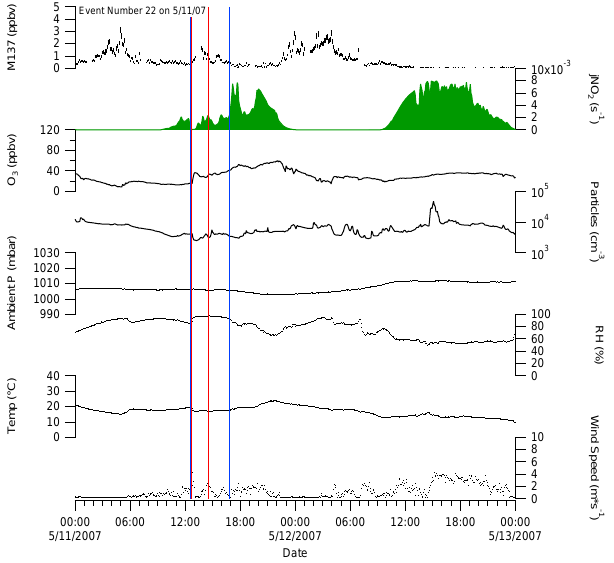
Fig. 5. An example of a Type C event, in which the storm pas- sage coincides with a decrease in monoterpene mixing ratios from 23 July 2005. In this example, no increase in precipitation rate be- yond 2.54mmh − 1 was detected.